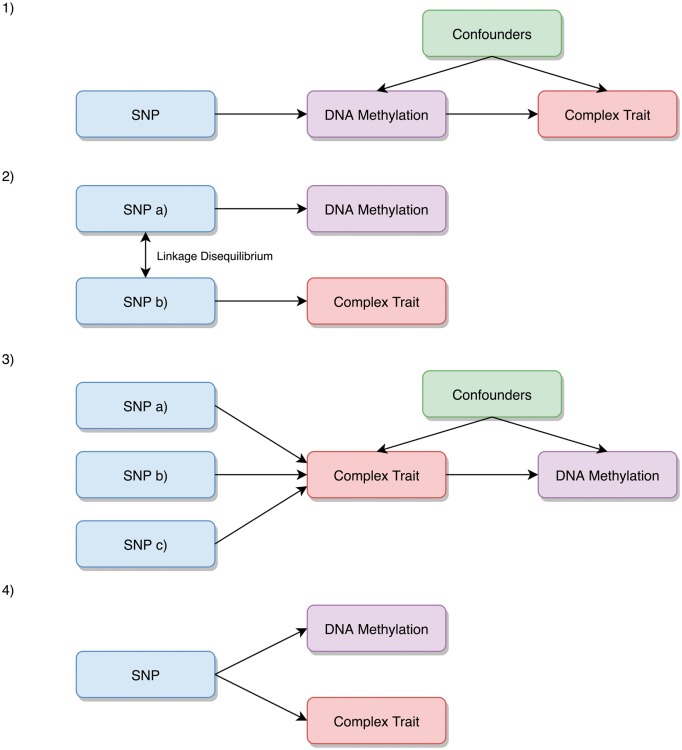
Explanations evaluated which may potentially explain associations between meQTL and trait outcomes. (1) The genetic variant has a causal effect on the complex trait which is mediated by changes in DNA methylation. (2) The genetic variant that influences DNA methylation is in LD with another variant that influences complex trait variation. (3) The genetic variant has a causal effect on the complex trait which subsequently influences DNA methylation at this locus. (4) The genetic variant influences DNA methylation and the complex trait via two independent biological pathways (also known as horizontal pleiotropy).